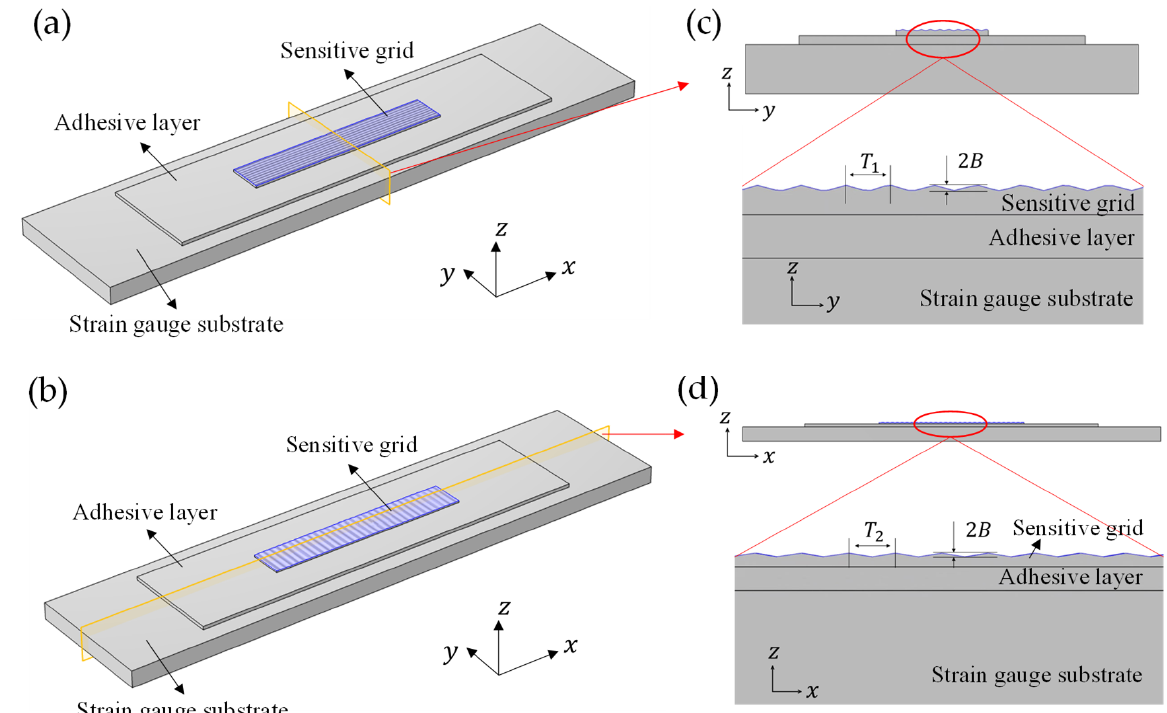
Figure 5. Schematic drawing of longitudinal ( a ) and transverse ( c ) surface textures in sensitive grids. The dimensional schematic of the sinusoidal shape in the cross section view along the longitudinal ( b ) and transverse ( d ) direction.